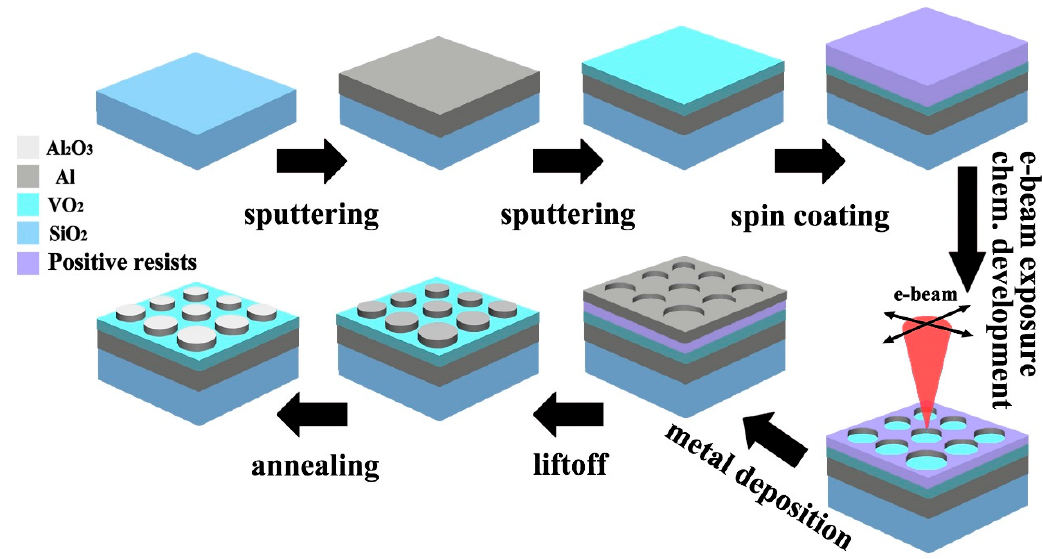
Figure 5. Fabrication flow for realization of the proposed optical switch.